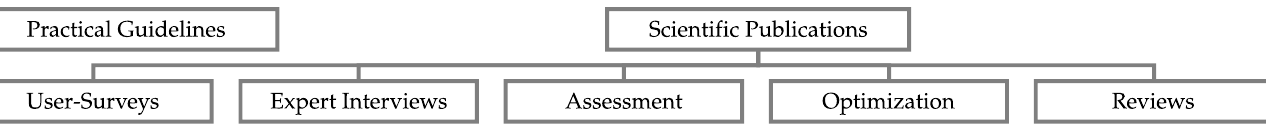
Figure 2. Types of literature considered in our